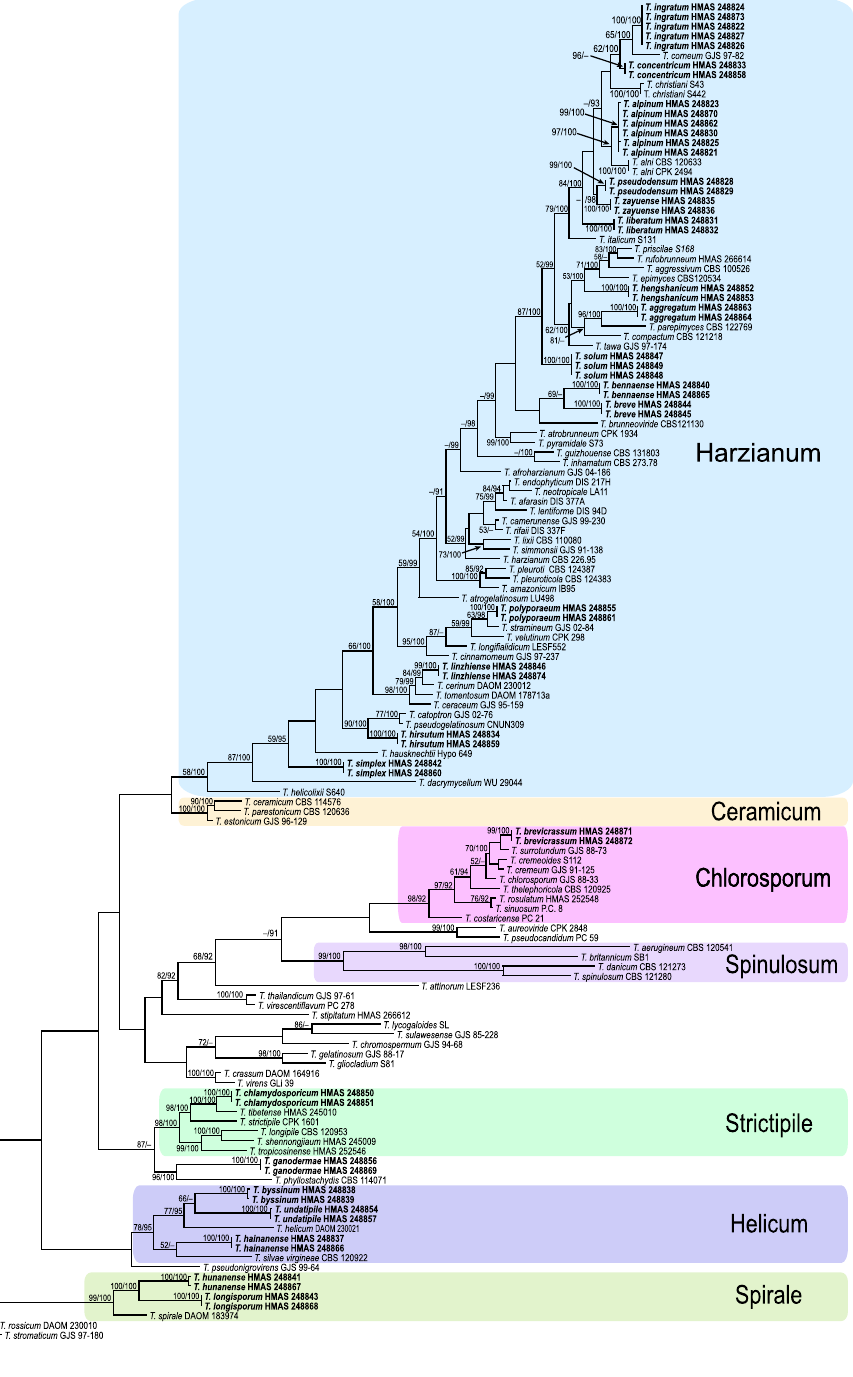
Figure 1. Phylogram generated from maximum parsimony analysis based on combined RPB2 and TEF1 sequence data of green-ascospored Trichoderma species with T. rossicum and T. stromaticum as outgroup taxa. MPBP above 50% (left) and BIPP above 90% (right) are indicated at nodes. New species proposed are indicated in